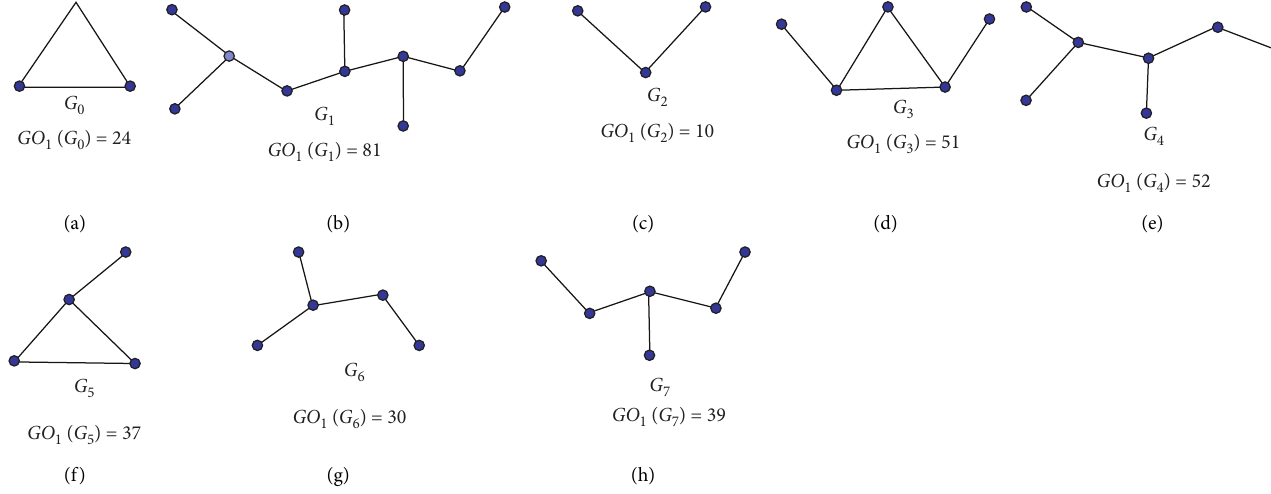
j � 0 , 1 , 2 , ... , 7 with first Gourava index values: (a) G j , for